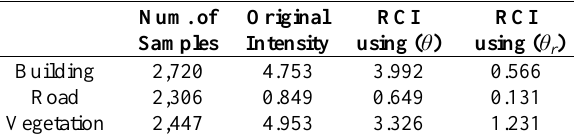
Table 1. Variance-to-mean ratio of different land cover features before and after radiometric correction.